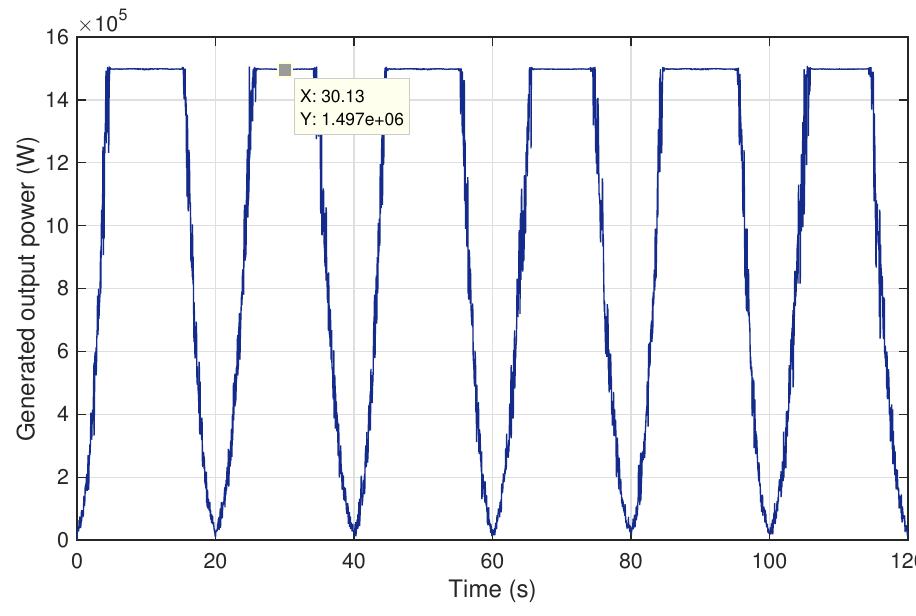
Figure 19. Case 1: Output power